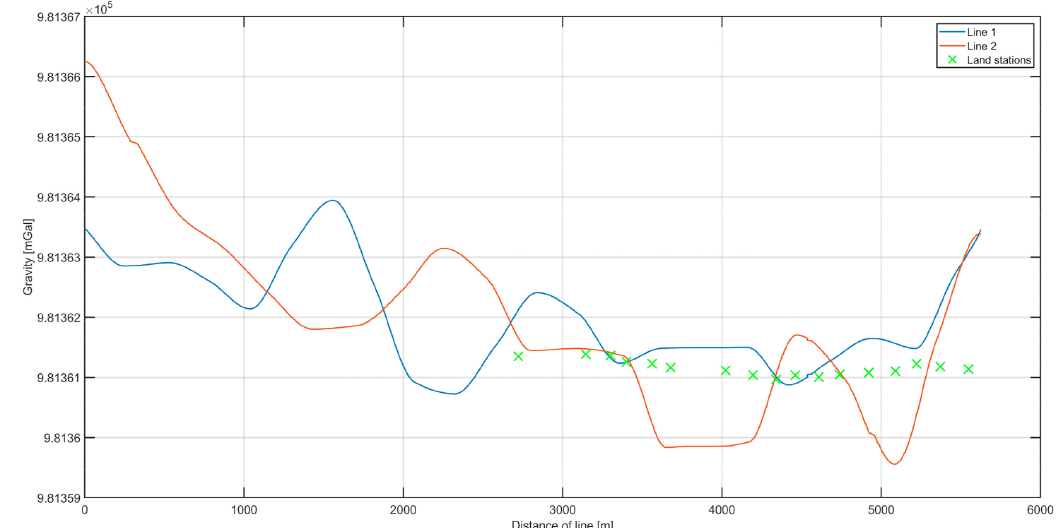
Figure 8. The superimposed values of gravitational acceleration on the two survey lines. In addition, land measurement points are marked, with the obtained values reduced to the height of the dynamic gravimeter.